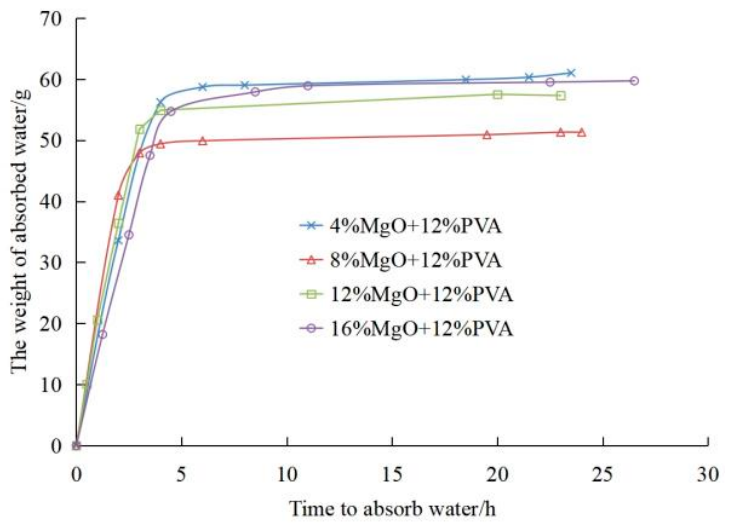
Figure 8. Absorption of capillary